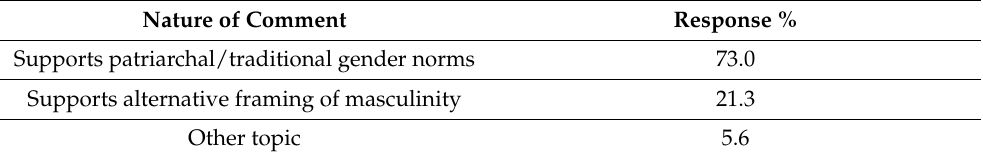
Table 5. Invited reflections on being a man in Australia today for younger men ( n = 89).